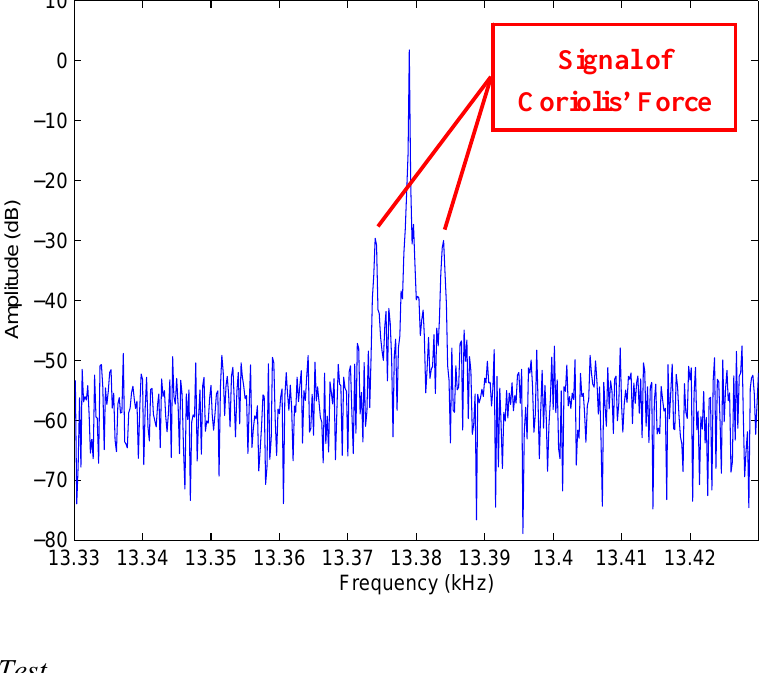
Figure 17. The frequency spectrum in case of angular rate